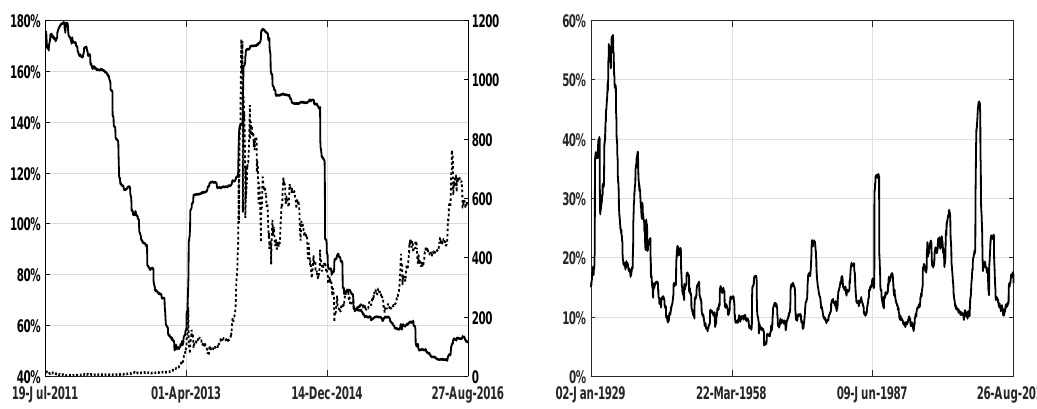
Fig. 1. Left: 1 year rolling volatility of bitcoin relative to USD daily returns vs date (contin- uous line and left axis) and daily price of bitcoin in USD (dotted line and right axes). Right: 1 year rolling volatility of SP500 Index daily returns vs